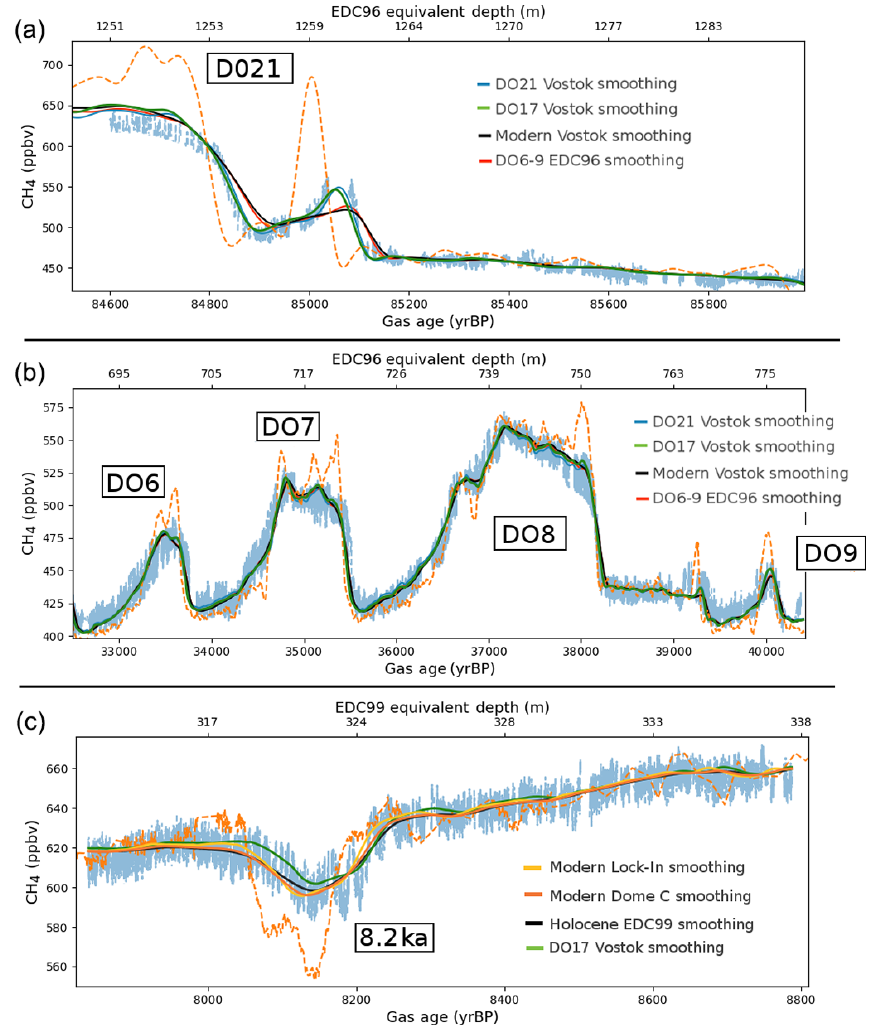
Figure 9. (a, b) Comparison of smoothing resulting from the three different glacial age distributions and the modern Vostok GAD constrained with firn air pumping data. Atmospheric references (dashed lines) have been smoothed by the four different GADs and are displayed overlying the measurements (light blue). Panel (a) shows the DO21 event as measured in Vostok, and (b) shows the DO6-9 as measured in EDC96. (c) A comparison of the smoothing induced by three different Holocene and a glacial age distributions. The atmospheric reference for the 8.2ka event (dashed line) has been smoothed by the four different GADs and displayed over the EDC99 measurements (light